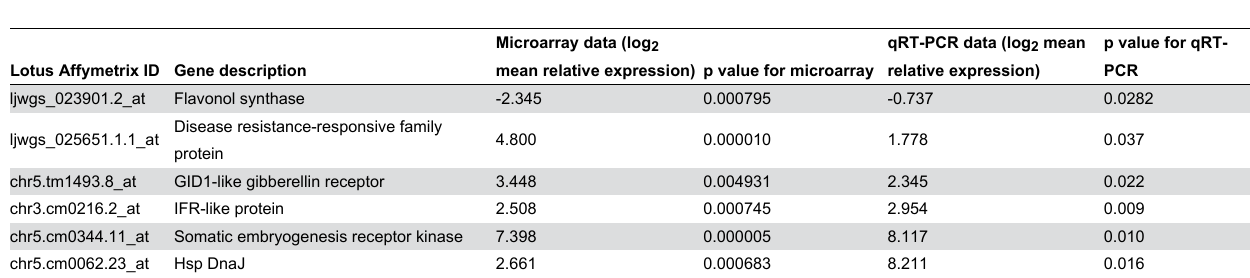
Table 2. Comparison of the relative expression levels in Gifu B-129 vs. MG-20 of selected genes as determined by microarray (mock-inoculated samples) and qRT-PCR (non-inoculated samples).